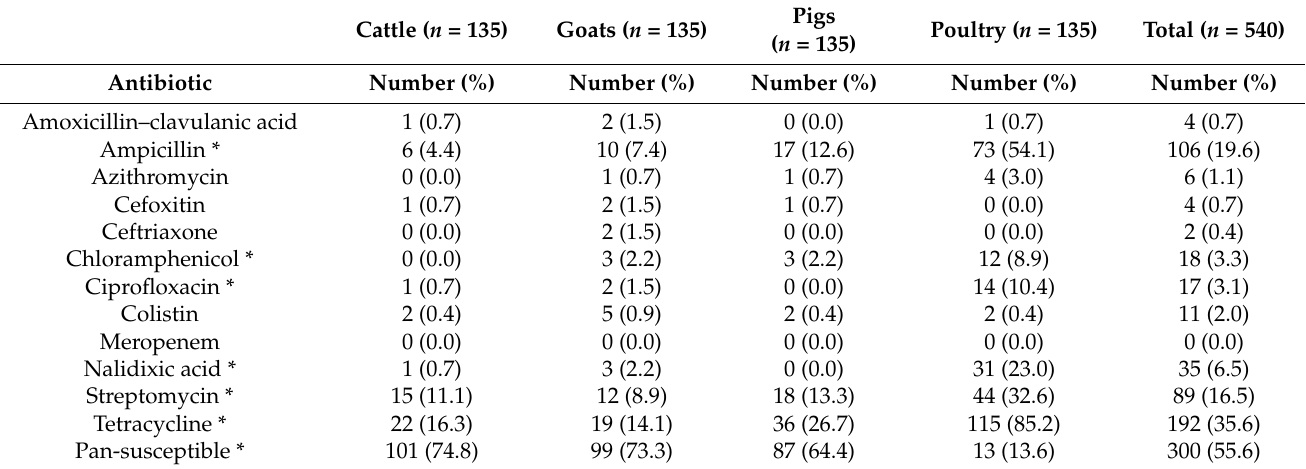
Table 2. Resistance to antibiotics among E. coli from food animals in the East province of Rwanda.